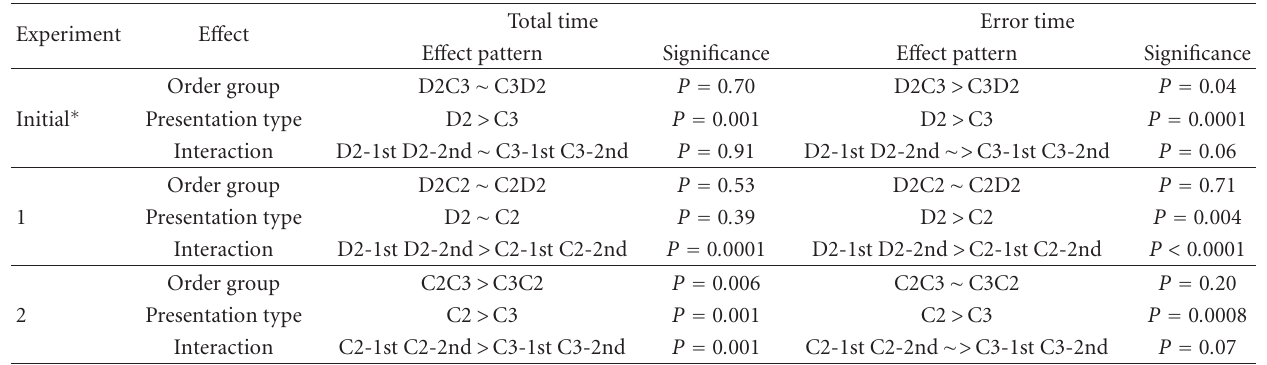
Table 1: The pattern of e ff ects in all experiments—collapsing (averaging)